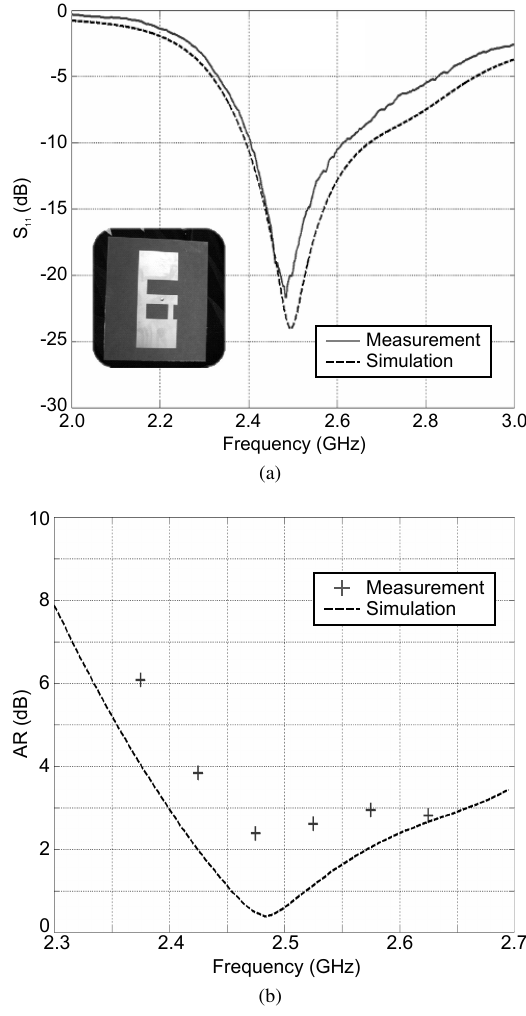
FIGURE 10. Simulated and measured performance of the optimized, RHCP CP E-shaped patch antenna using a shorting bar approach. (a) Impedance matching. (b) Broadside axial ratio (AR). Adapted from